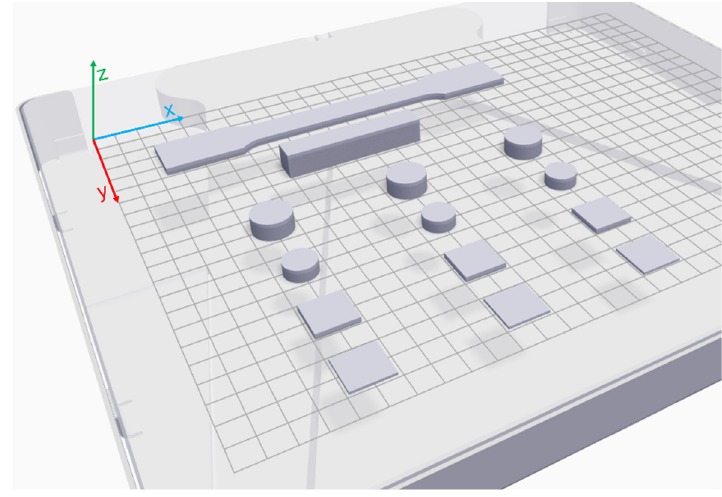
Figure 4. Printing strategy followed in each sample. Table 1. Printing parameters for the additive manufacturing of copper parts by